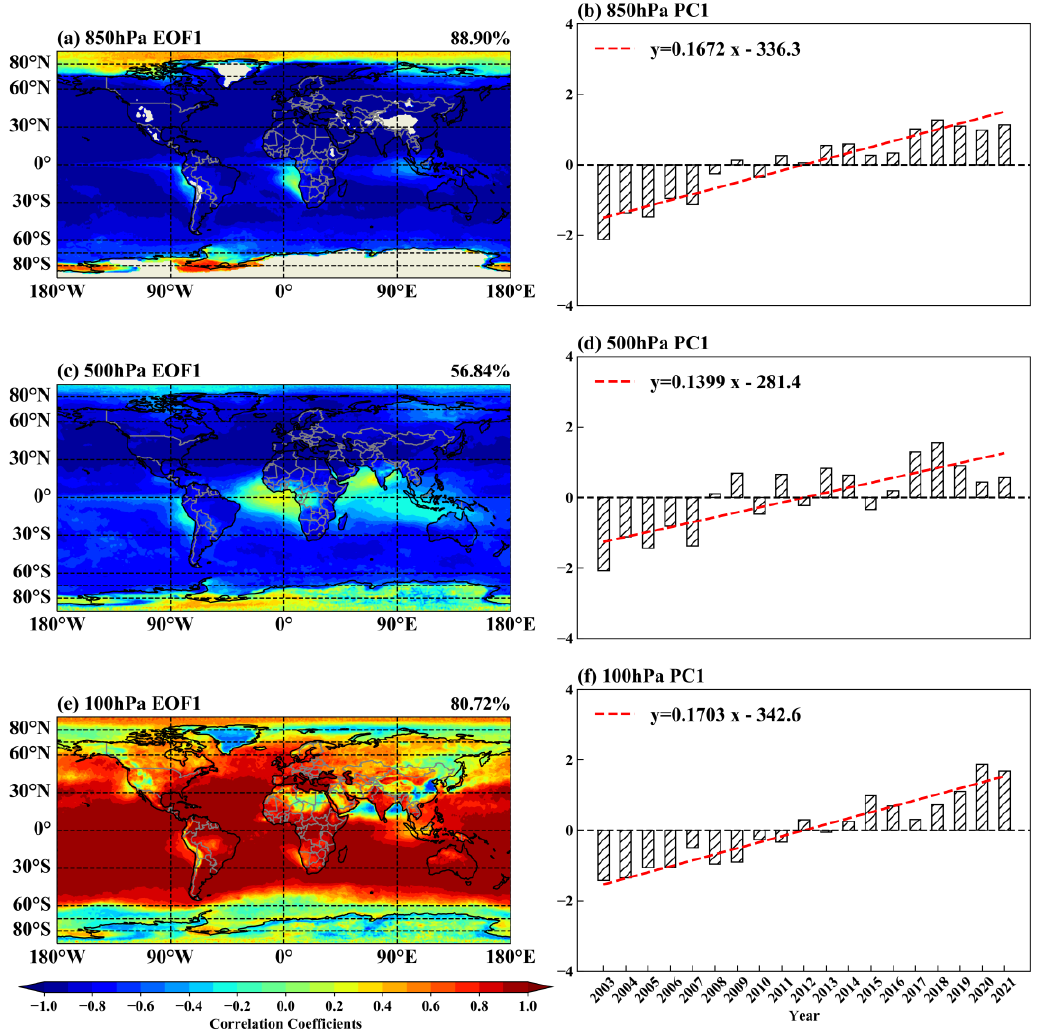
Figure 13. EOF spatial distribution map and time coefficient map of global tropospheric CO concen- tration from 2003 to 2021. ( a , b ) 850 hPa; ( c , d ) 500 hPa; ( e , f ) 100